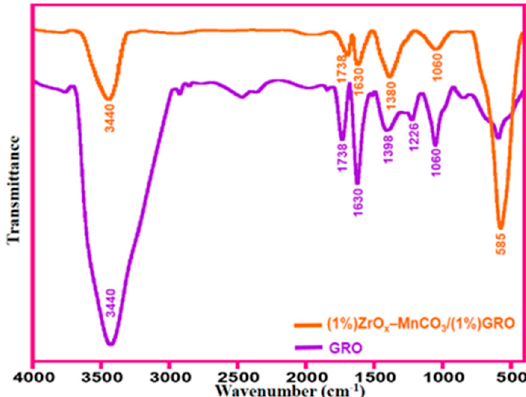
Figure 3. Raman spectra of un-supported (1%)ZrO x –MnCO 3 catalyst and